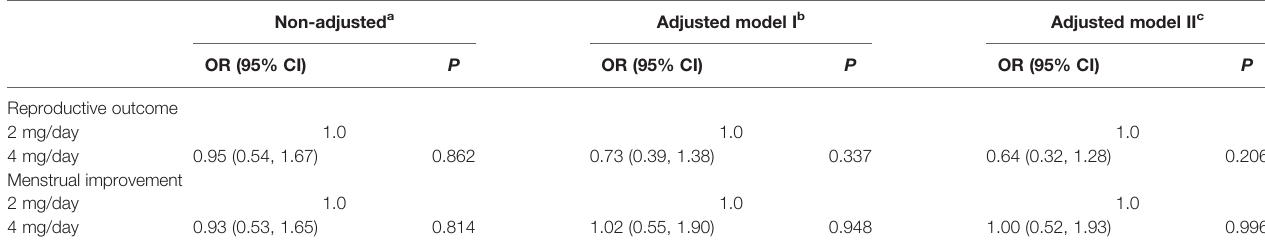
TABLE 2 | Relationship between the daily dose of estradiol valerate and the reproductive outc ome and menstrual improvement in different